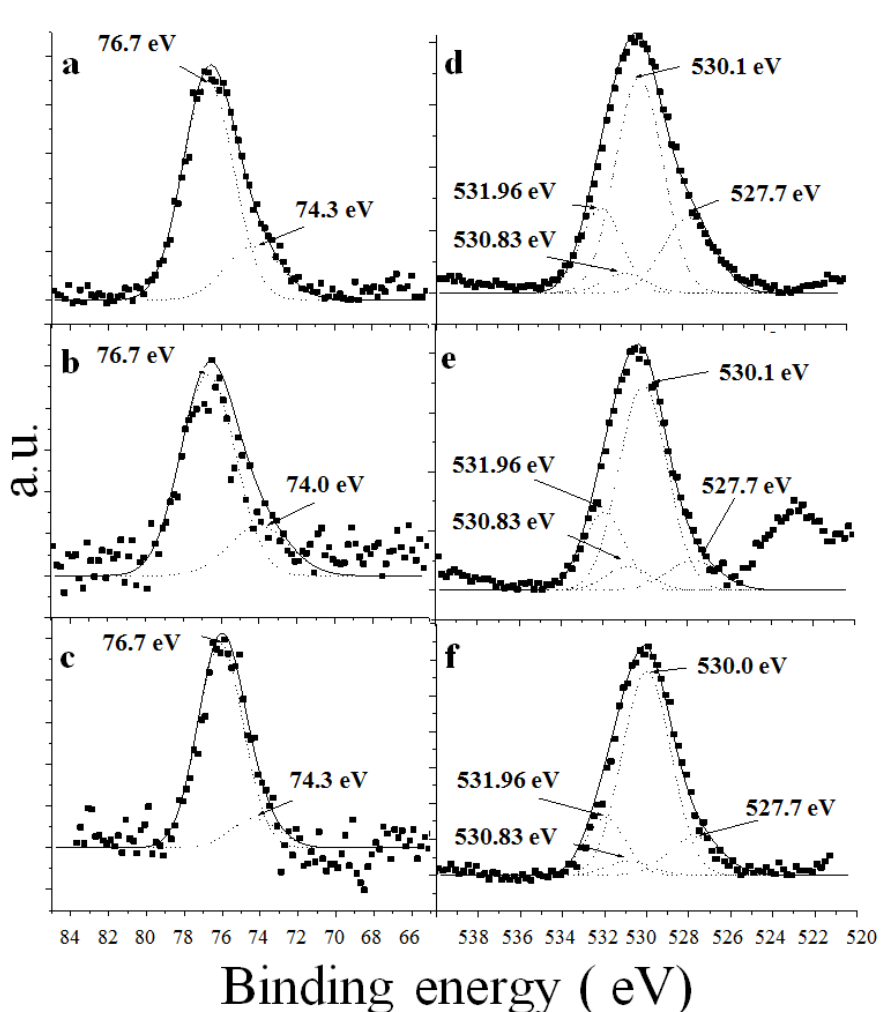
Figure 6. High-resolution Al 2p X-ray photoelectron spectra (XPS): ( a ) A; ( b )